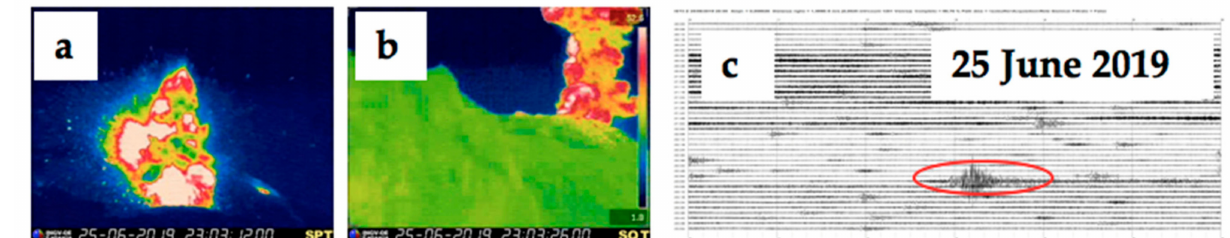
Figure 3. ( a ) Thermal image from the SPT camera of the CC vent with the start of the explosion on 25 June 2019 at 23:03:1200, view from S. Blue is cold, white is hot. ( b ) Thermal image from the SQT camera showing the eruptive plume at 23:03:2600, view from NE. Blue is cold, white is hot. ( c ) Seismic trace of the explosive event as recorded from the IST3 seismic station, Z component, with the red oval marking the explosive event here considered. See Figure 1 for station